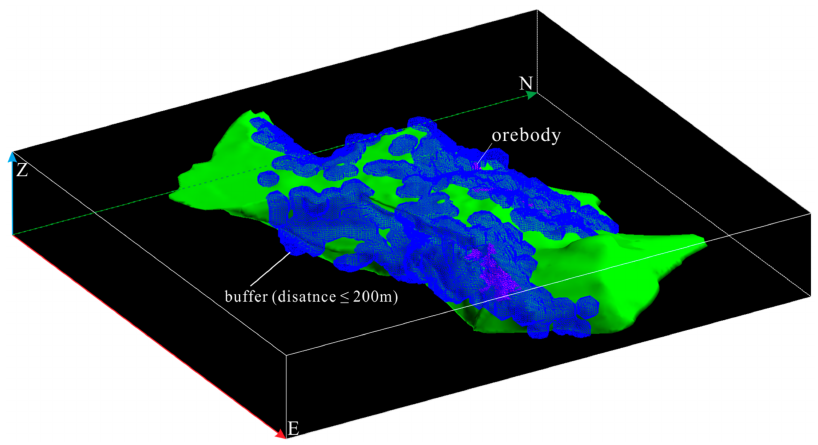
Figure 7. Spatial association of orebodies with distance to intrusion contact zone, showing the buffer within 200 m from the chosen abnormal zones, and it almost contains all the orebodies. Table 1. Weights for 3D buffers around the chosen abnormal zones of Yueshan intrusion